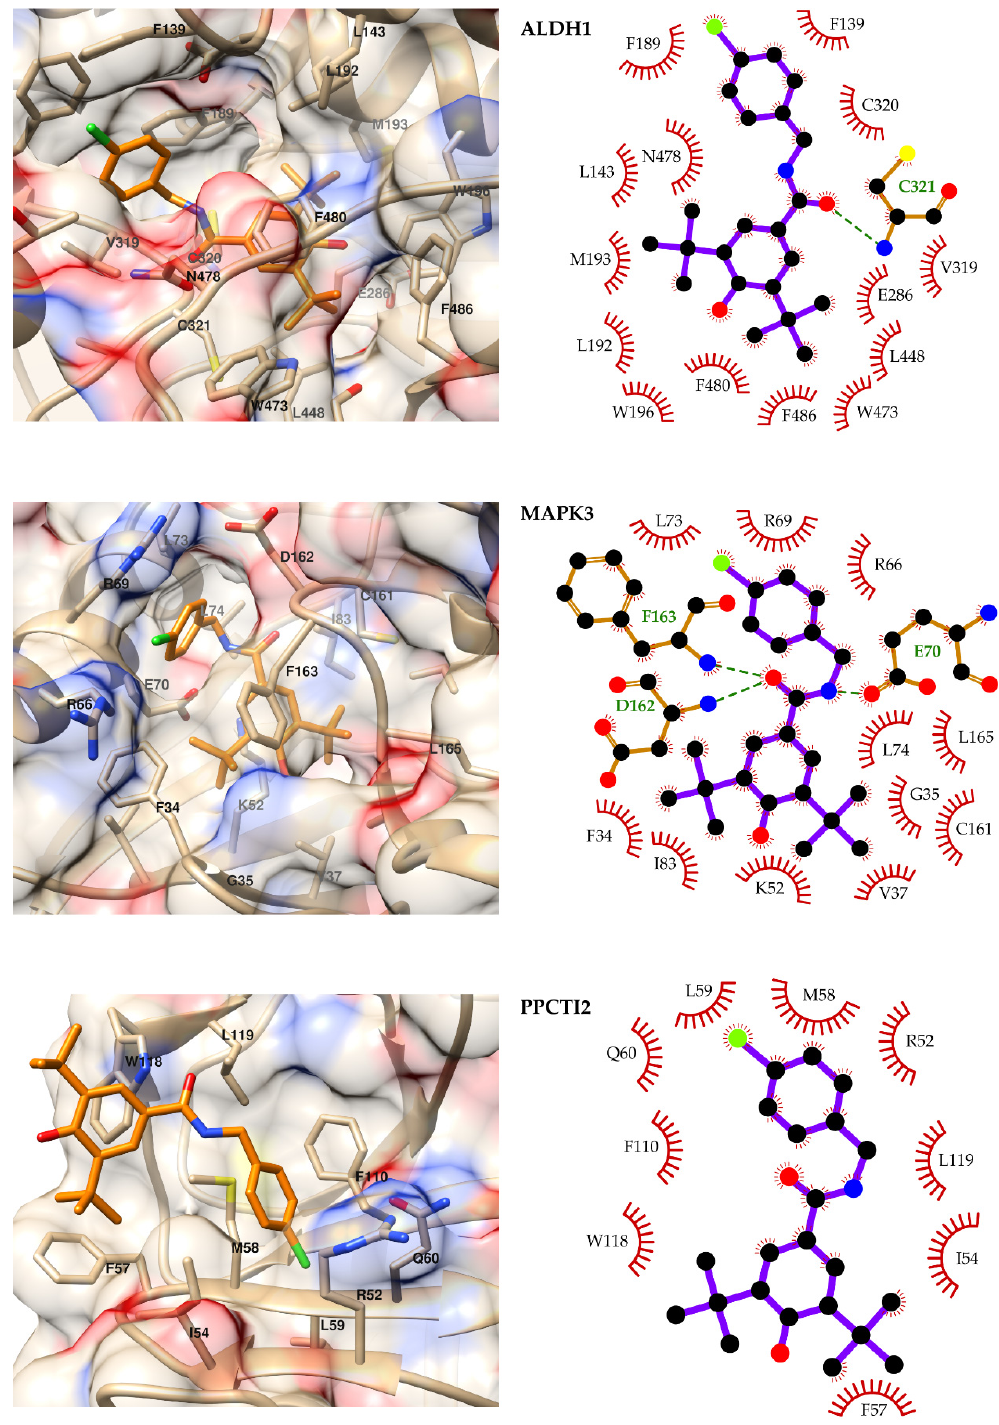
Figure 2. Predicted binding modes of compound 16 to ALDH1, MAPK3 and PPCTI2 ( left ) and diagrams of the predicted ligand–receptor interactions ( right ). For representing the predicted binding modes, compound 16 is depicted in orange, and the following scheme is used for non-carbon atoms: oxygen is red, nitrogen blue, chlorine green and sulfur yellow. In the interaction diagrams ( left ), carbon atoms are depicted in black, and heavy atoms are represented only for residues forming hydrogen bonds with the ligand.